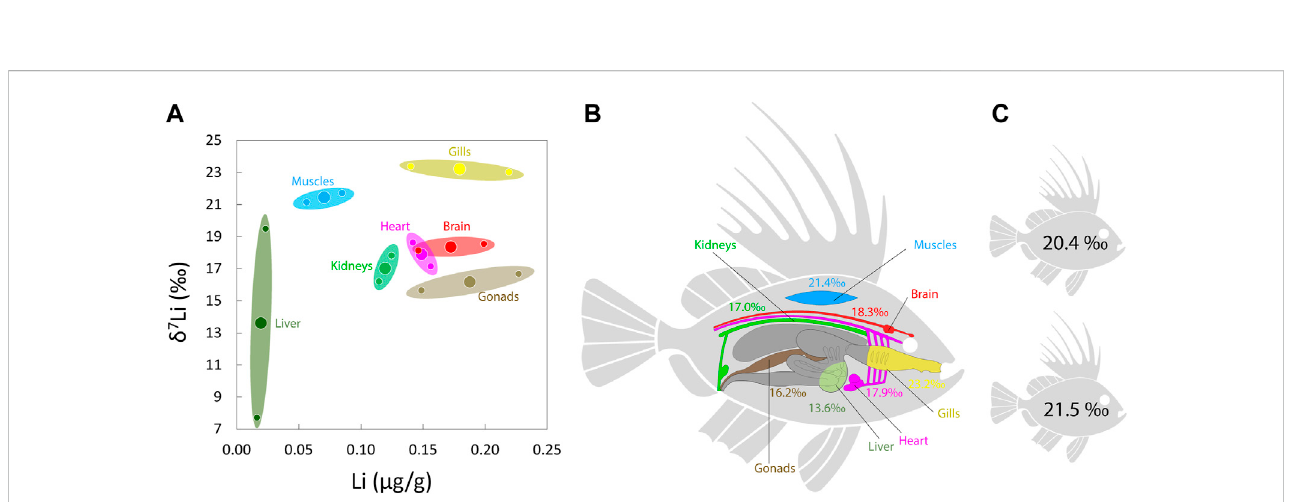
FIGURE 5 (A) Li isotope compositions vs. tissue Li concentration of two John Dory ( Z. faber ) fi sh. Large circles represent the mean of the values from the two individuals. (B) Schematic representation of organs Li isotope compositions. (C) Whole body δ 7 Li of the two individuals calculated from mass balance equations. Colors code for each